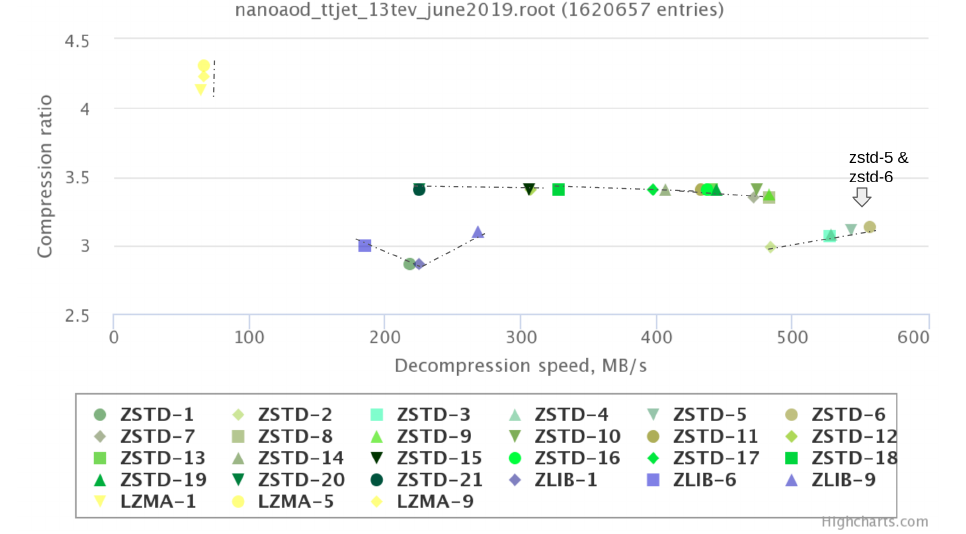
Figure 1. Comparison of compression ratio and decompression speed for ZLIB, LZMA and ZSTD algorithms for NanoAOD 2019